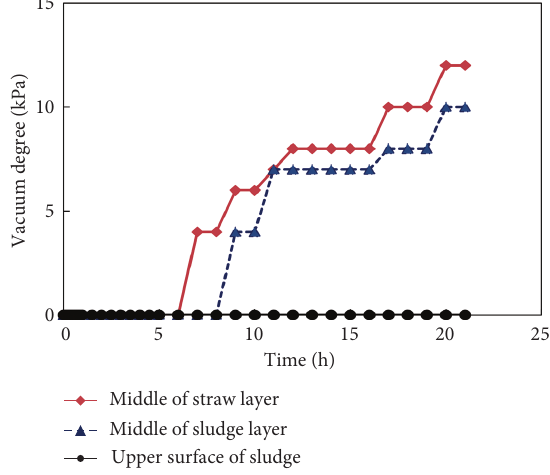
Figure 13: The vacuum degree at the monitoring points.